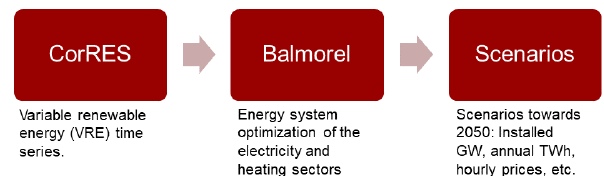
Figure 1. The scenario modelling flow chart.